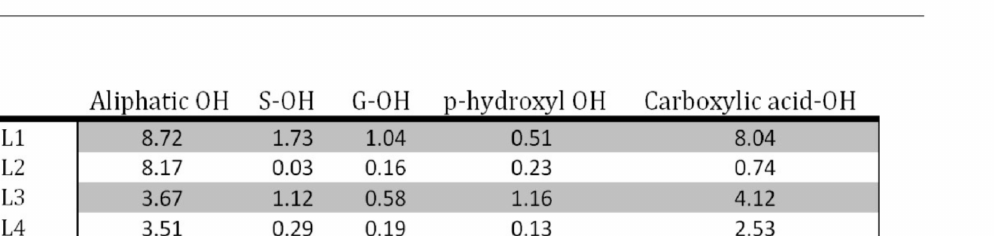
Figure 6. 31 P-NMR spectra of kraft lignin purification fractions: L1, L2, L3, and L4. The table shows the corresponding OH number in the